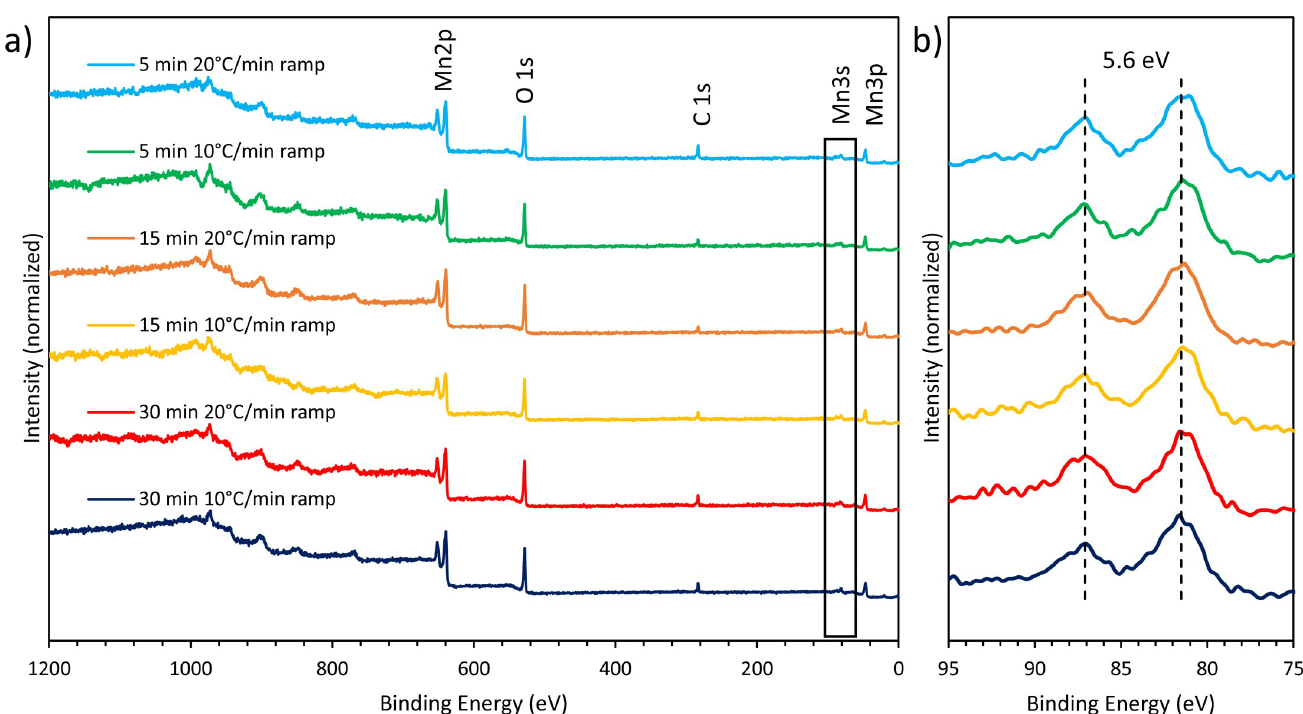
Fig 5. XPS spectra of MnO NP samples for each temperature profile showing the a) whole spectral region and b) the Mn3s region. The whole spectral region indicates the presence of manganese, oxygen, and carbon in the NP samples, while the Mn3s region shows peak splitting characteristic of surface oxidation to Mn 3 O 4 (Mn 2+ /Mn 3+ oxidation states).